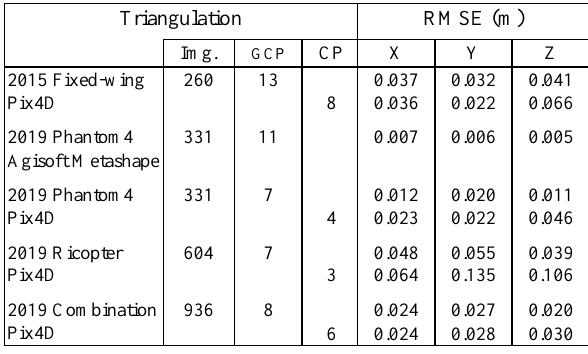
Table 4. Results of image orientation